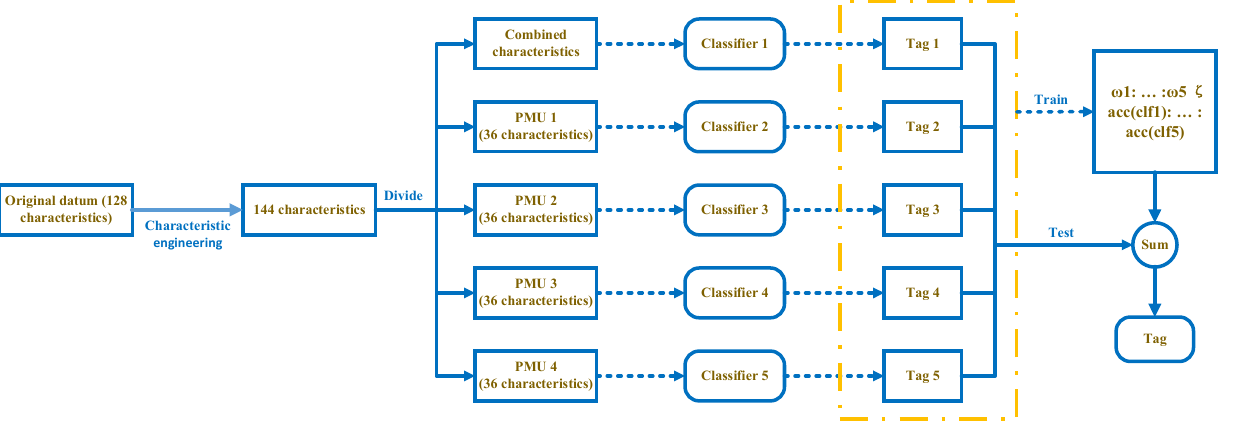
Figure 2. Explanation of layout to detect disturbance and cyber-attack in electrical networks.